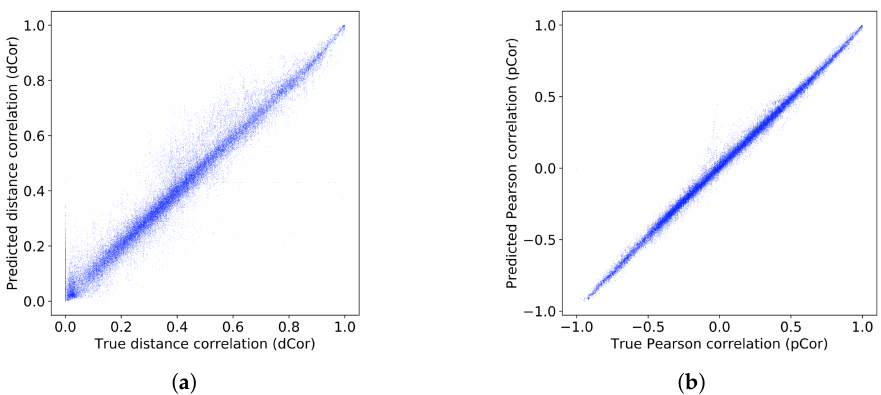
Figure 6. Scatter plot of the true correlations against the predicted correlation on the test set: ( a ) dCor regression results; ( b ) pCor regression results. Note that the subfigures ( a , b ) have different